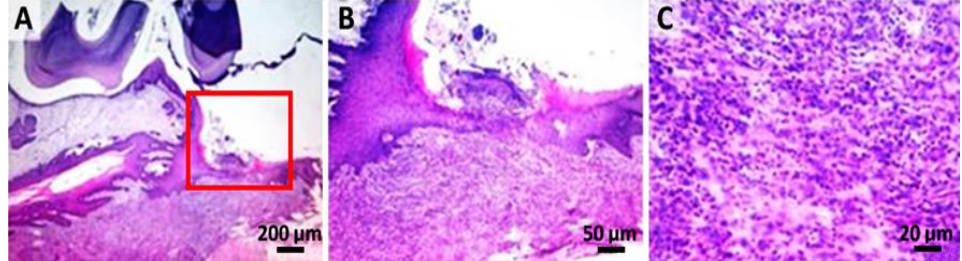
Figure 7. GC group: ( A ) hyperplasia and marked hyperkeratosis of the gingival epithelium. The superficial gingival area presents a focal ulcer (minimal), covered by a serocellular crust mixed with cellular debris and forage (the area demarcated by the rectangle); ( B ) higher resolution, 50µm, of the marked zone with red; ( C ) detail of inflammatory granulation tissue, with the abundance of neutrophils (viable and degenerate) in combination with rare mononuclear and reactive fibroblasts. In the GO group, marked gingival epithelial hyperplasia and hyperkeratosis (orthokeratosis) and partial replacement of the dental ligament with partially oriented fibro-vascular